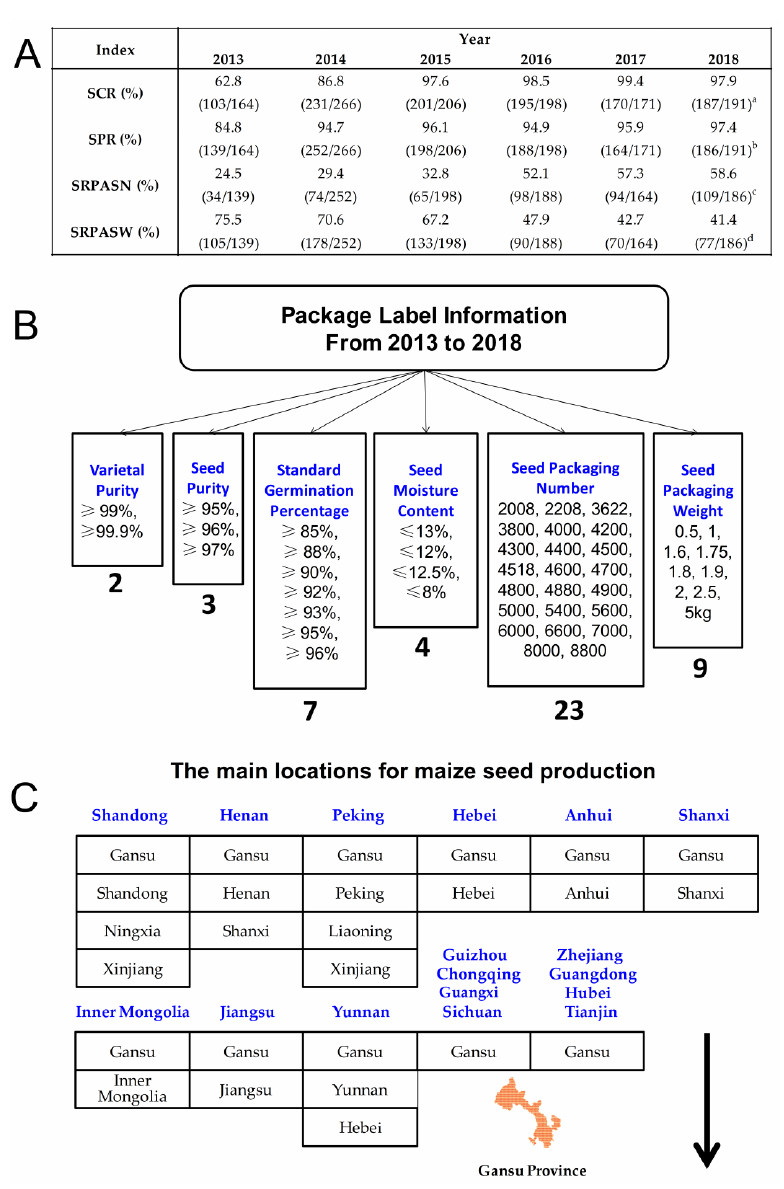
Figure 2. Survey results for sample coating, packaging, packet identification, and related information. ( A ) Comparative analysis of sample coating rate (SCR, namely the percentage of samples with coated seed), sample packaging rate (SPR), sample rate of packaging according to seed number (SRPASN), and sample rate of packaging according to seed weight (SRPASW) from 2013 to 2018. ( B ) Survey analysis of the types of seed purity, varietal purity, standard germination percentage (SGP), seed moisture content, seed packaging number, and seed packaging weight of the packing label. ( C ) The main locations for maize seed production in NHNSS. Note: a, number of coating samples / number of total samples; b, number of packaging samples / number of total samples; c, number of packaging according to seed number samples / number of total packaging samples; d, number of packaging according to seed weight samples / number of total packaging samples. NHNSS, north, Huanghuai, northwest, southwest and south